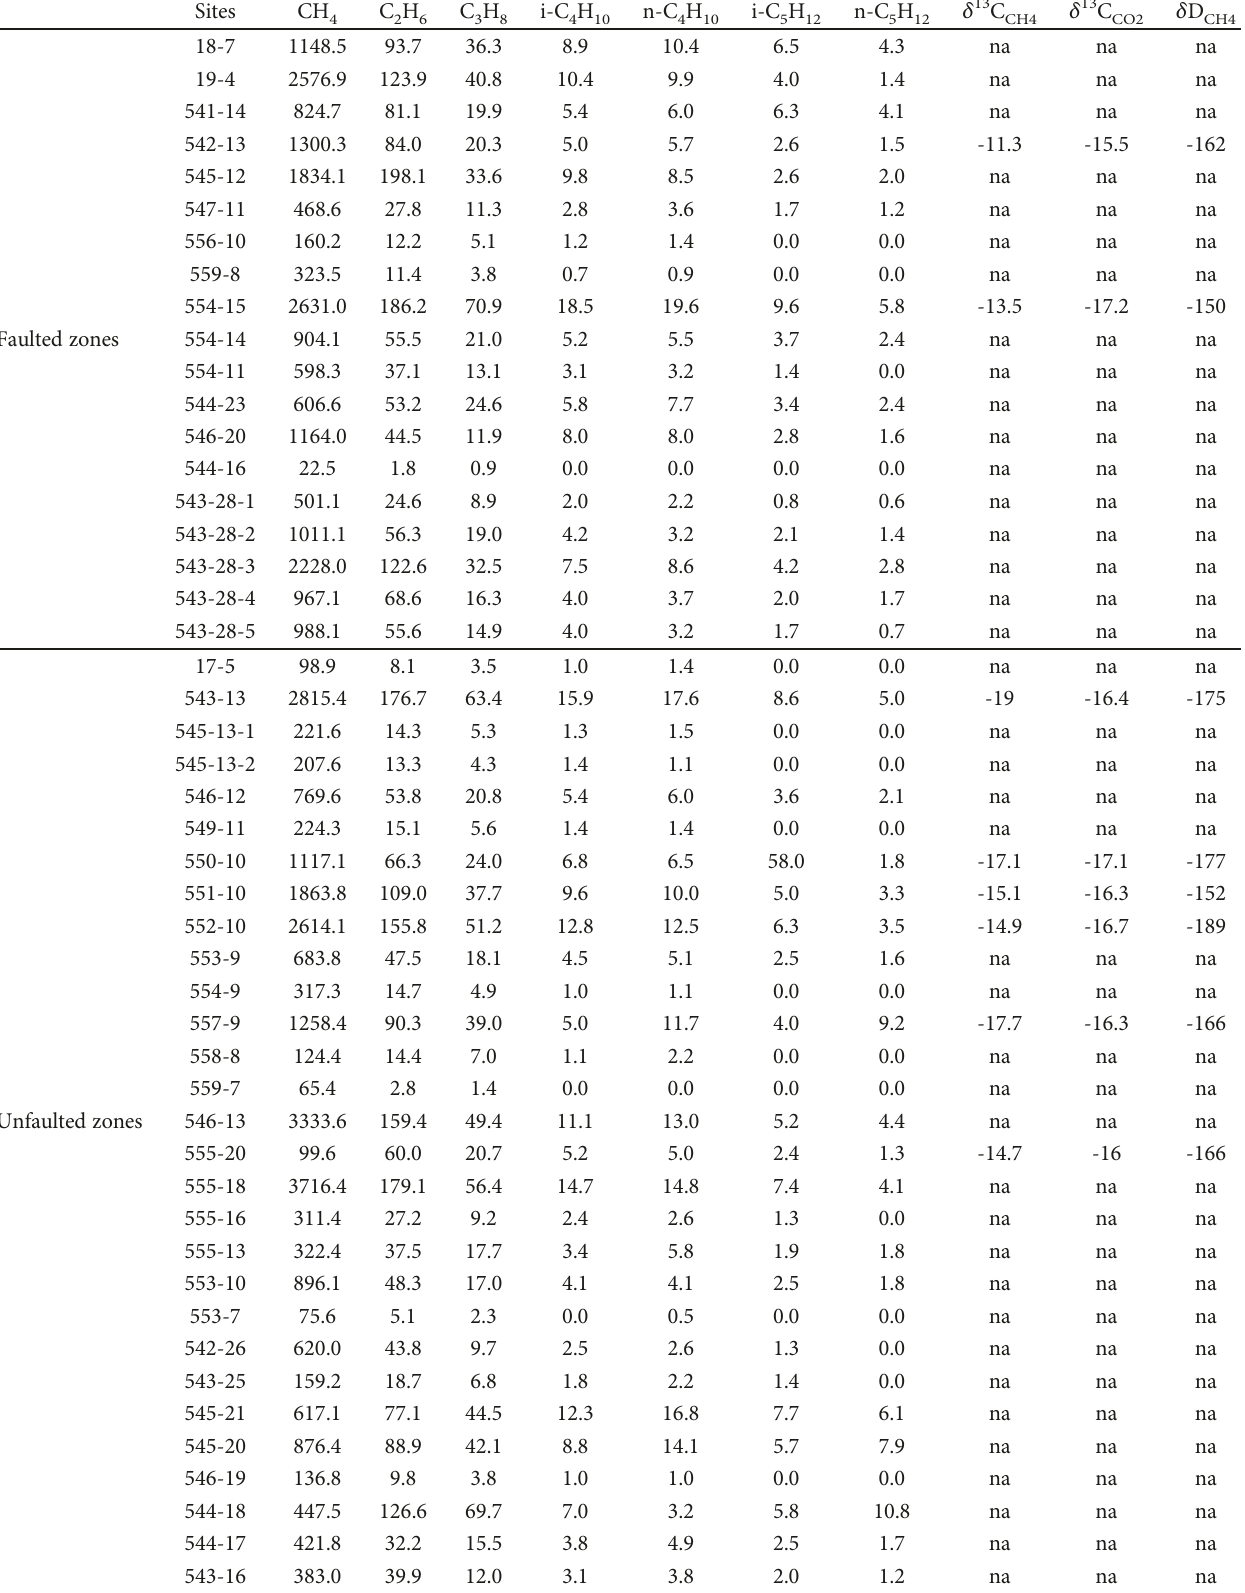
Table 2: Molecular and isotopic composition of soil gas